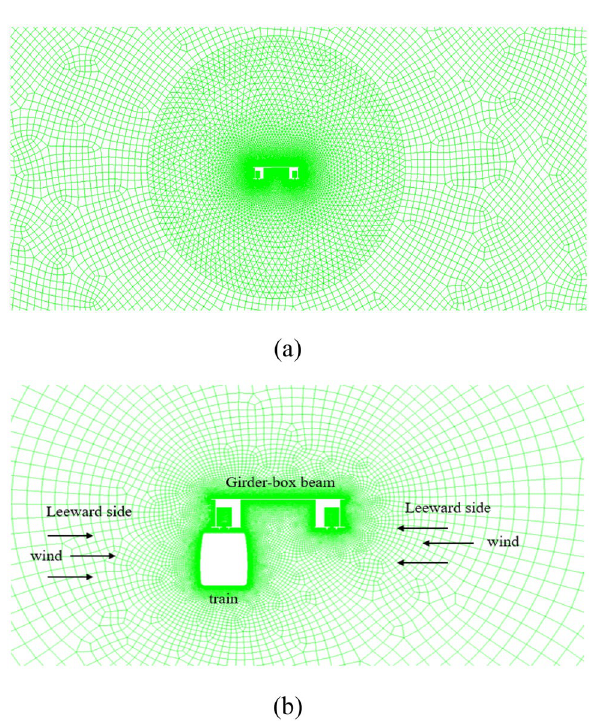
Fig. 7 CFD model of STM mesh schematic diagram. a box-girder; b box-girder and